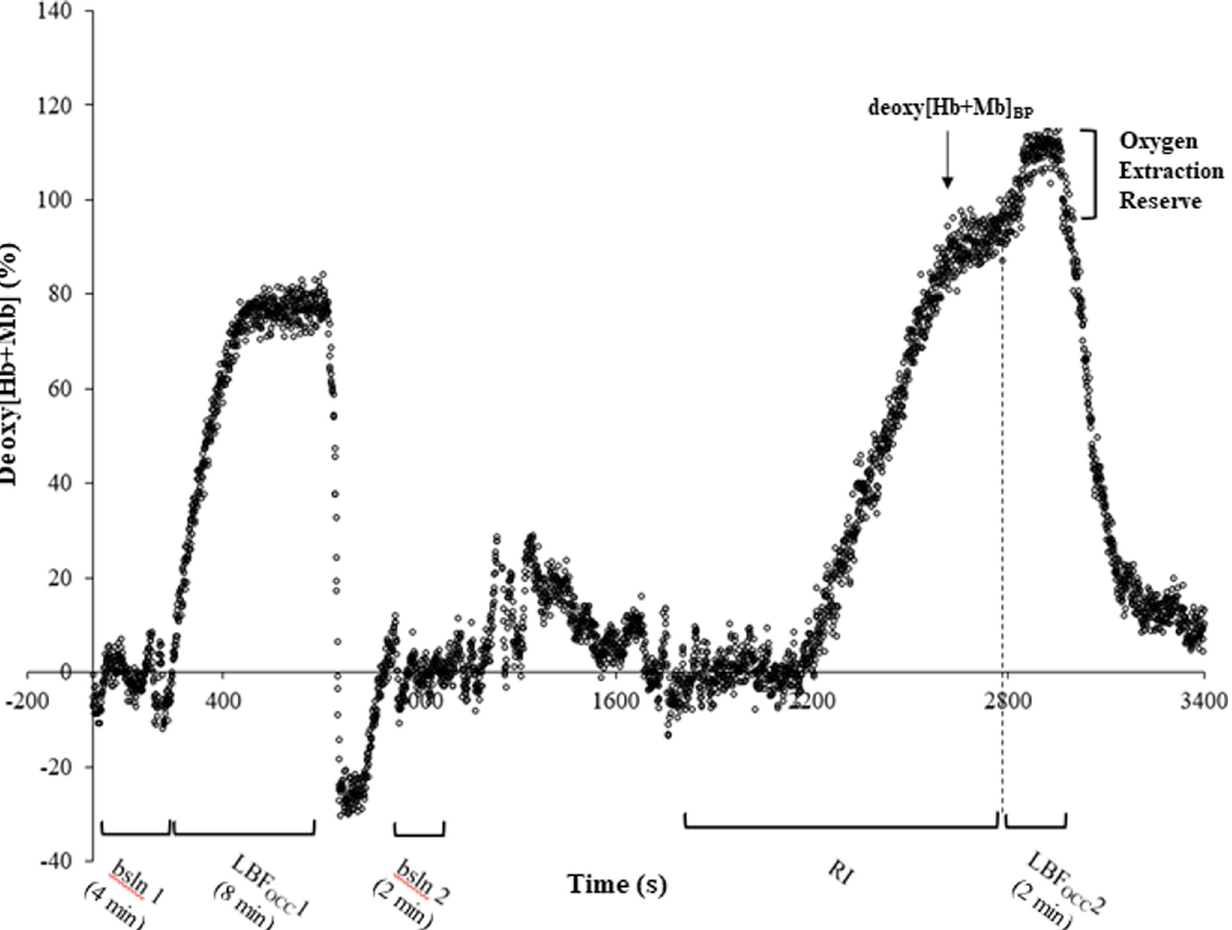
Fig 1. Overview of the deoxygenated hemoglobin concentration (deoxy[Hb+Mb]) signal during the entire protocol for one participant (bsln 1 and 2, Baseline 1 and 2; LBF OCC 1 and 2, leg blood flow occlusion 1 and 2; RI, ramp incremental test; deoxy[Hb+Mb] BP , deoxygenated hemoglobin concentration break point).